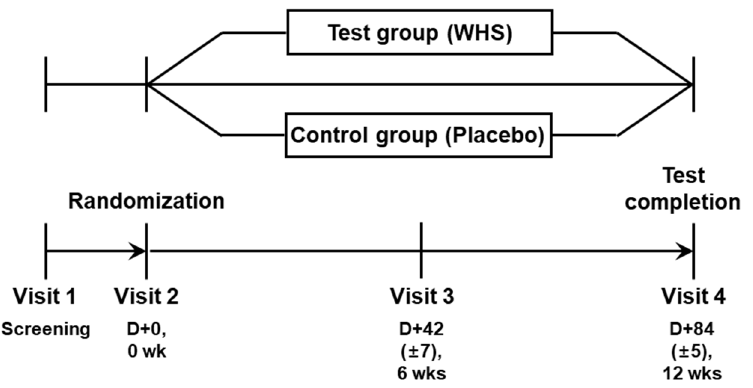
Figure 1. Process of